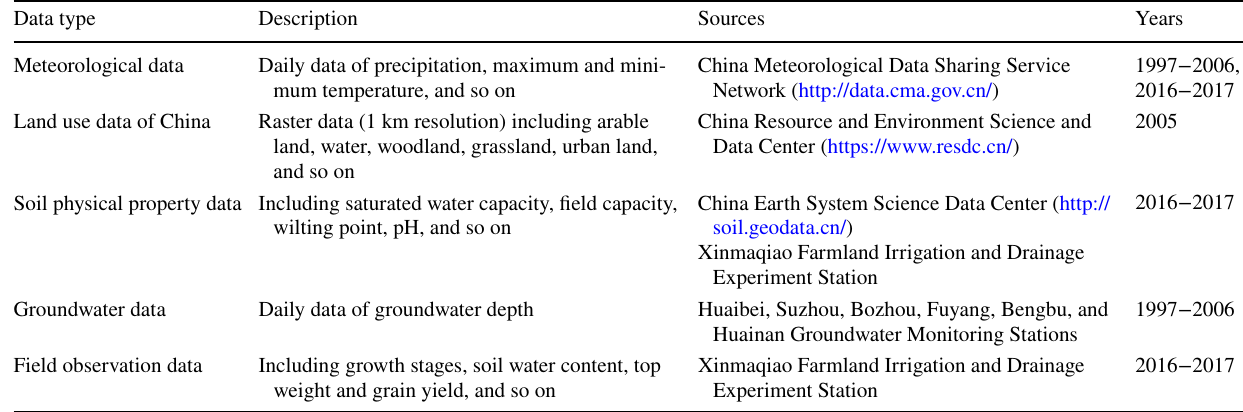
Fig. 1 Location of the Huaibei Plain study area in northern Anhui Province: meteorological stations, experiment stations, and groundwater mon- itoring stations Table 1 Database types and sources for the assessment of agricultural drought vulnerability of the Huaibei Plain, Anhui Province,